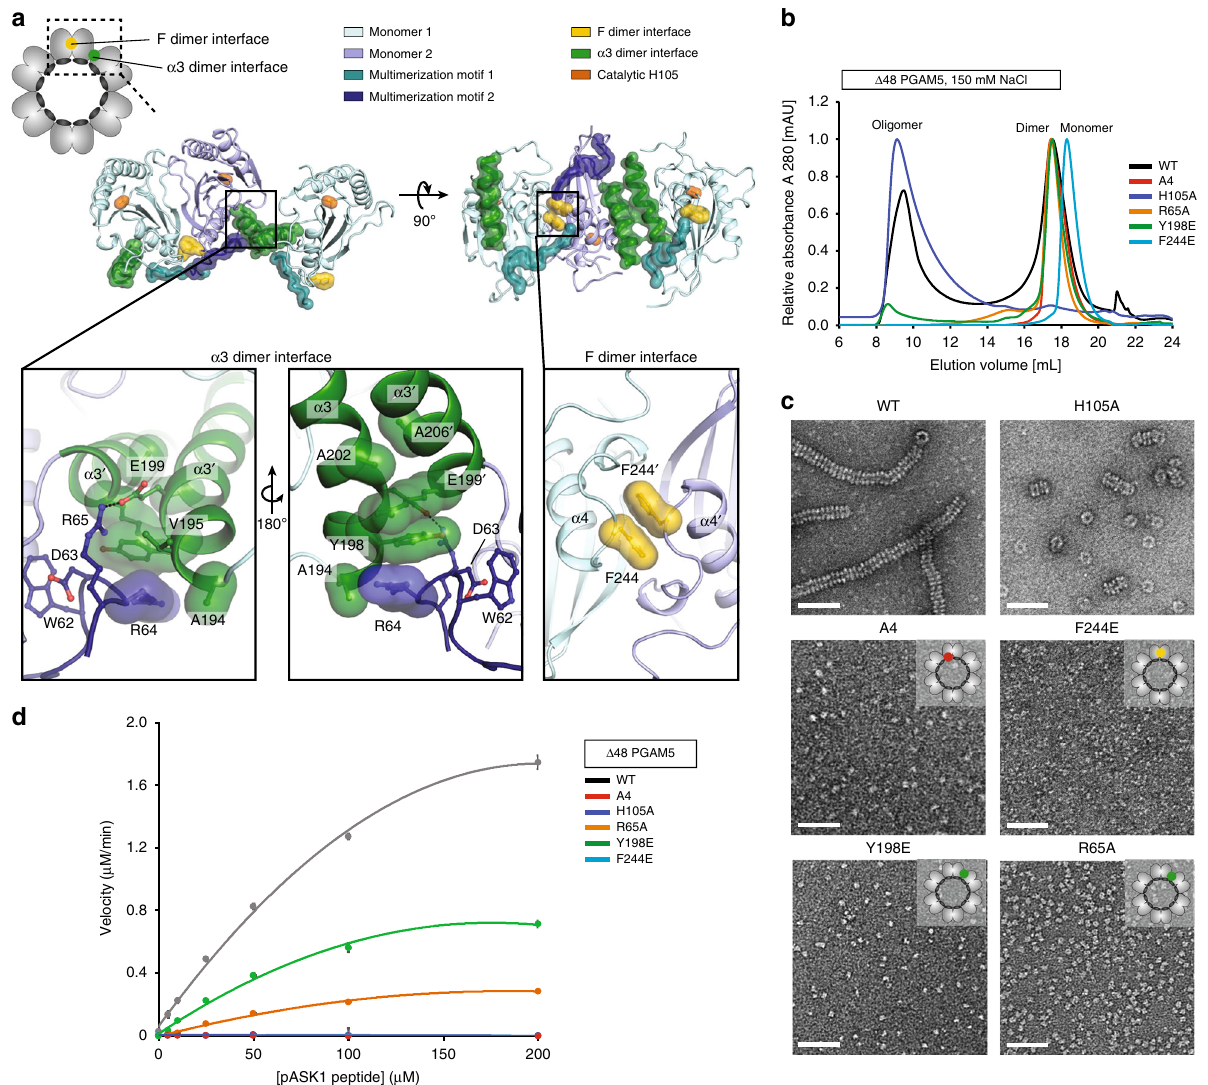
Fig. 4 PGAM5 multimerization is required for catalysis. a Overview of interactions contributing to the stability of the dodecamer assembly in the structure of Δ 90 PGAM5 H105A/MM. b SEC elution pro fi les of wild type (WT) and interface-disrupting mutants (R65A, H105A, Y198E, F244E, and A4) of Δ 48 PGAM5 in 150 mM NaCl-containing buffer, highlighting the effect of the MM (R65A, A4), and dimer interface (F244E, Y198E) mutants on the oligomer/ dimer equilibria observed for wild-type Δ 48 PGAM5. c EM micrographs of negatively stained samples of interface mutants of PGAM5 corresponding to the oligomer peaks for WT and H105A, and dimer/monomer peaks for all the other mutants as shown in b . The insets in top right corners illustrate the position of the respective mutations within the PGAM5 dodecamer cartoon. Scale bars correspond to 50 nm. d Phosphatase activity of the WT and mutant variants of Δ 48 PGAM5 measured for 20 nM enzyme and varying concentrations of a phosphorylated ASK1 substrate peptide. Data are represented as mean ± S.E. M. The kinetic parameters K m , k cat , and k cat / K m were determined using GraphPad Prism and are summarized in Table positions of R64 and R65 in the Δ 54 PGAM5 structure are occupied by R65 and E66 in the Δ 90 PGAM5 H105A/MM structure, respectively (Fig. 3c, d; Supplementary Figures 2e, 4). In Δ 90 PGAM5 H105A/MM, R64 is positioned directly in the center of a dimerization interface mediated by the α 3 helices (Fig. 3c, right panel), expanding the network of interactions in this region.